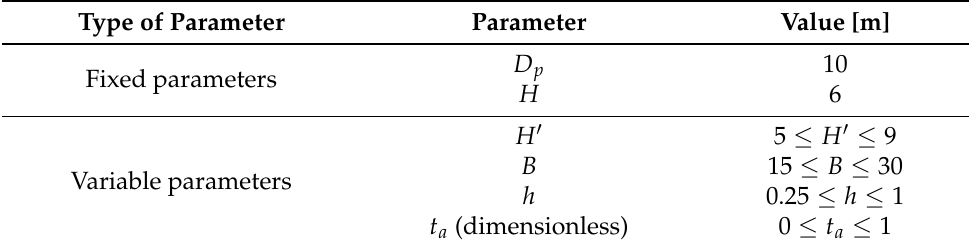
Table 2. Design parameters for the case in which the height H is fixed.